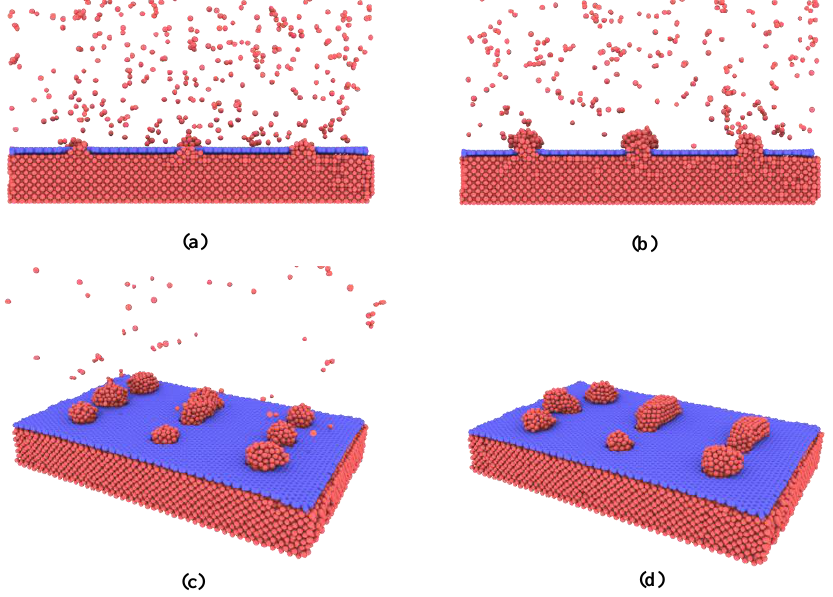
Figure 2. Atomic configurations of Cu atoms deposition onto the graphene at various stages. ( a ) Filling of nanopores at the initial stage; ( b ) Insular growth to nanoislands; ( c ) Further growing of nanoislands; ( d ) Joining with neighboring nanoislands.